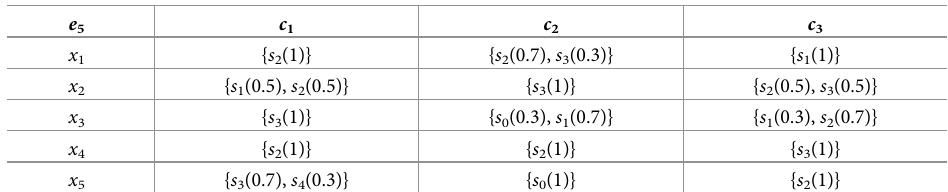
Table 5. The decision matrix of e 5